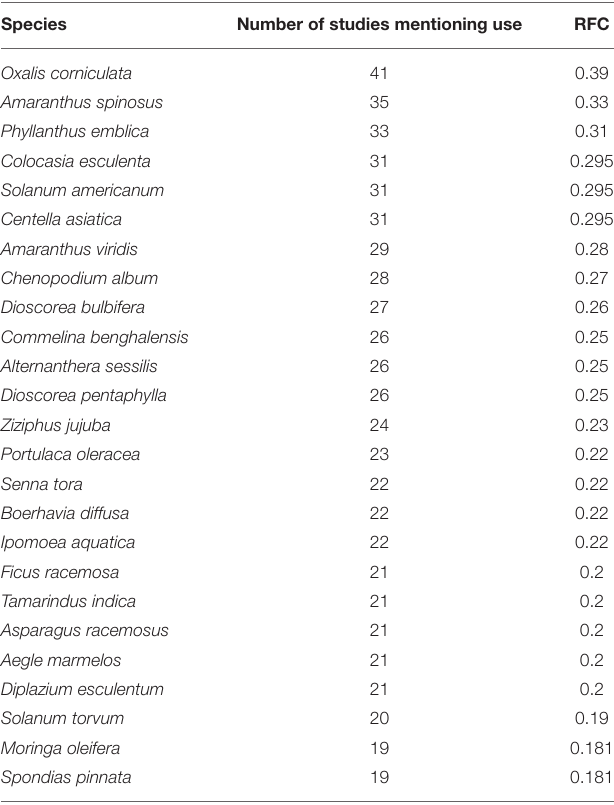
TABLE 3A | A list of species with high RFC value (up to 50% of the maximum). Species